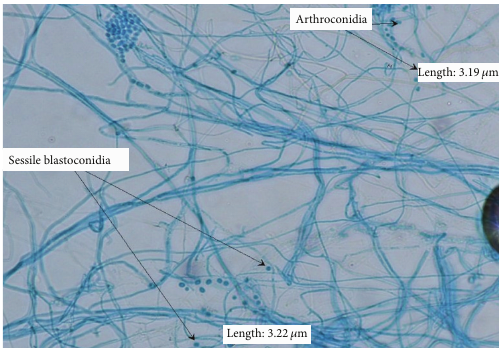
Figure 1: Microscopic examination of corneal scrape material stained with lactophenol cotton blue, demonstrating the presence of arthroconidia and lateral sessile conidia of hyaline fungal hyphae ( × 100 magnification).